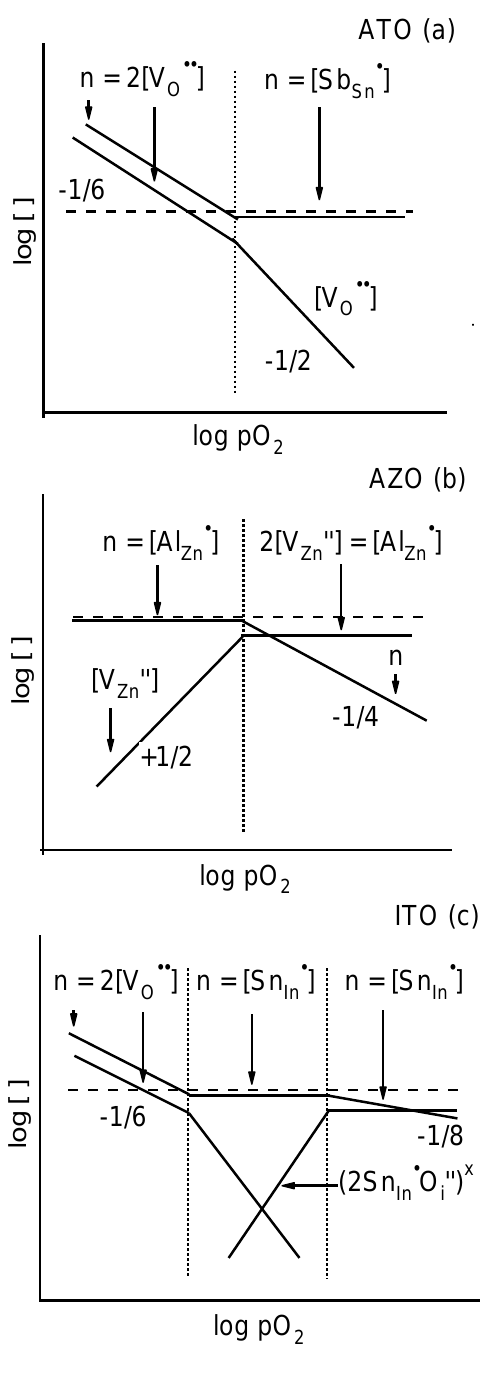
) for (a) SnO :Sb 2 2 ] ), doubly O